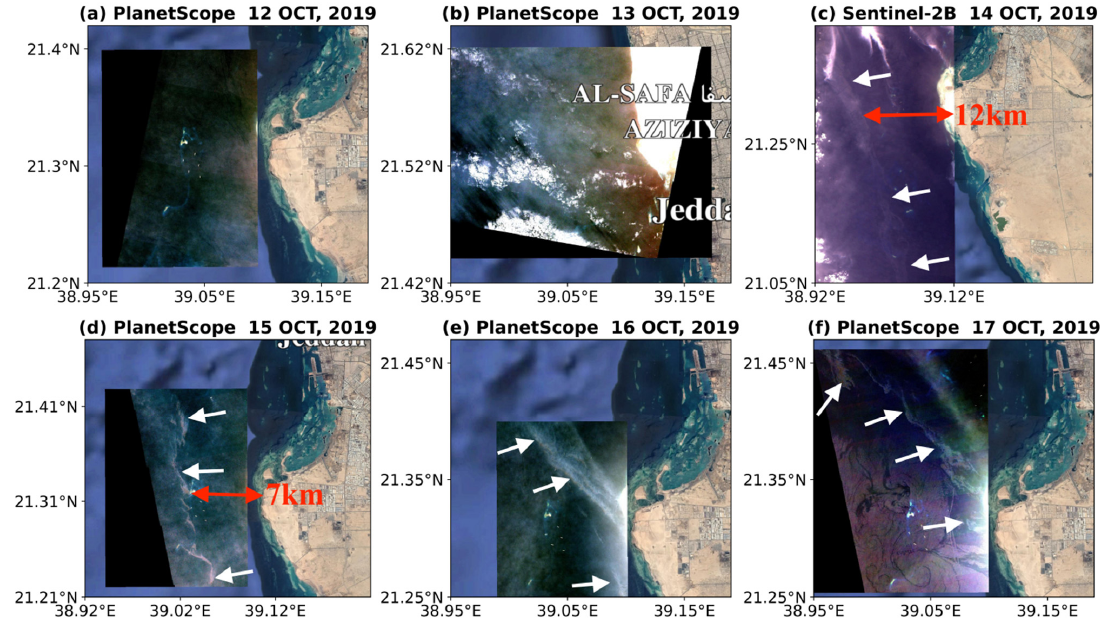
Figure 11. PlanetScope images on ( a ) 12 October 2019 (one day after the spill), ( b ) 13 October 2019 (two days after the spill), ( d ) 15 October 2019 (four days after the spill), ( e ) 16 October 2019 (five days after the spill), ( f ) 17 October 2019 (six days after the spill), and ( c ) the Sentinel ‐ 2A RGB (432) color composite image on 14 October 2019 (three days after the spill). The oil slicks detected from the images and their distances from the coast are labeled on the images. The red double arrows represent the distance of the oil spill from the coast and the white arrows indicate the oil slicks.